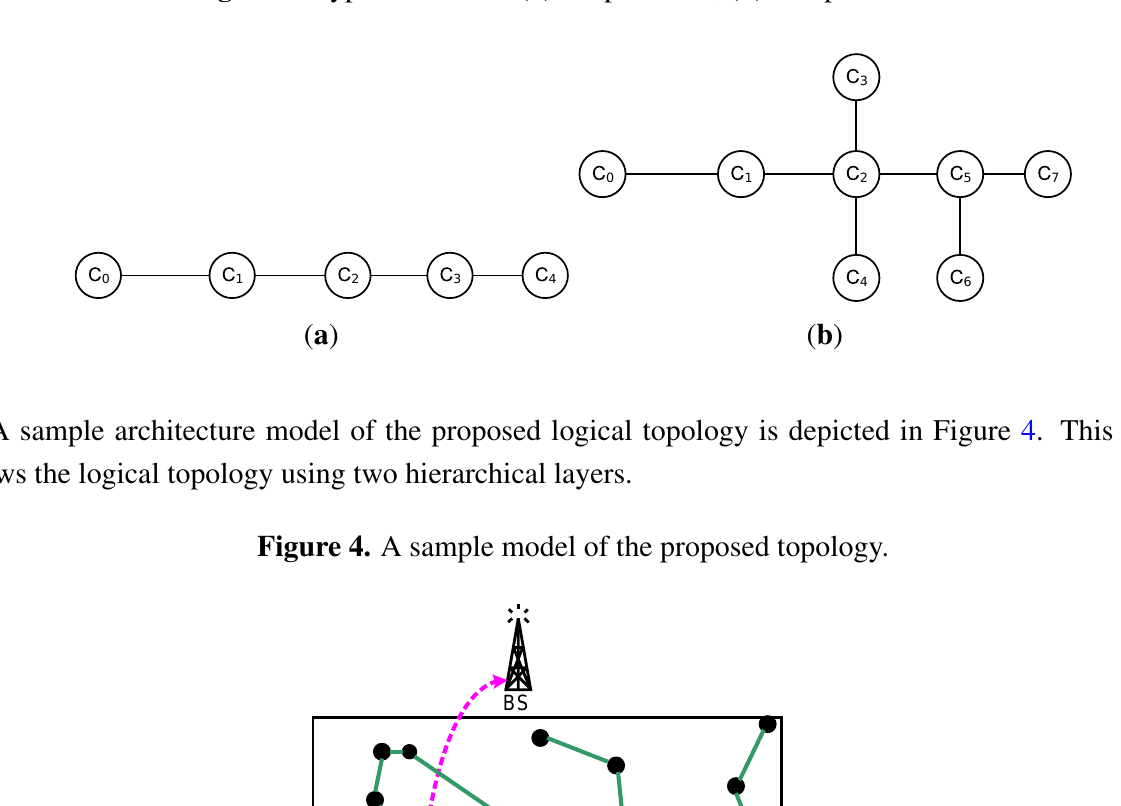
Figure 3. Types of chains: ( a ) simple chain; ( b ) complex chain.